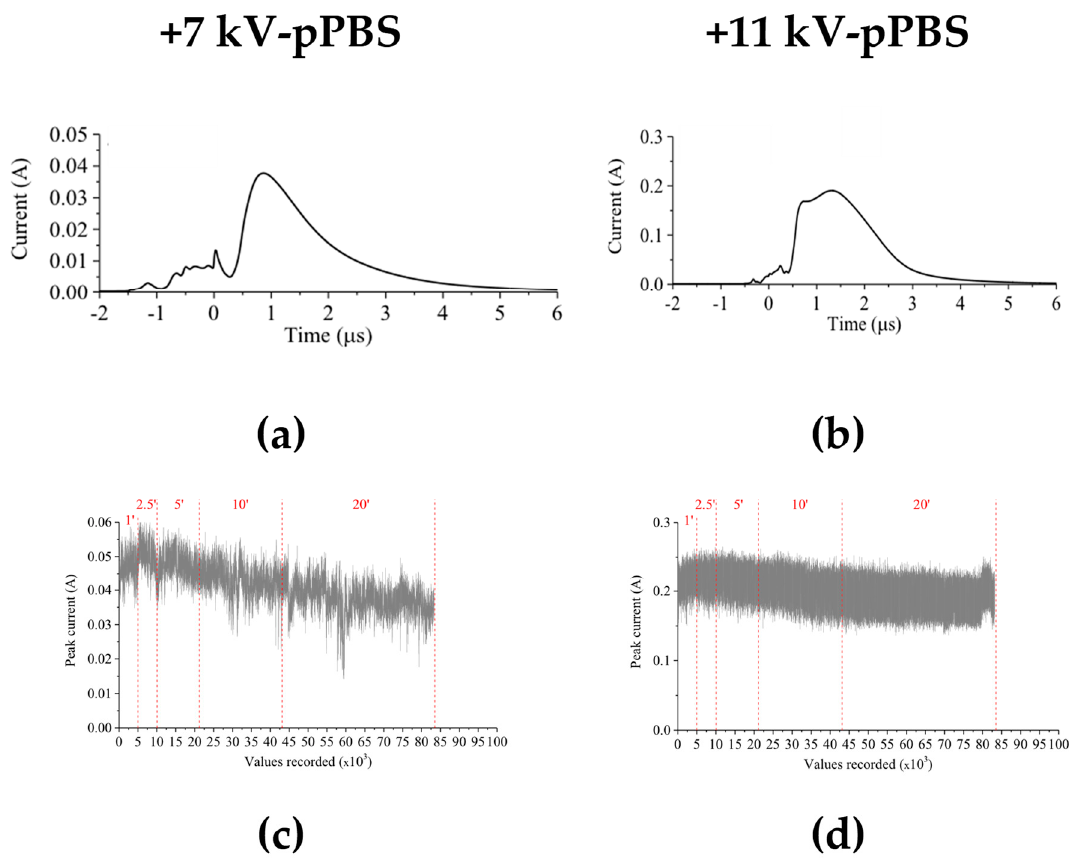
Figure 1. Assessment of the electrical characteristics of the non-thermal plasma (NTP) multi-jet source during 20 min. treatment of PBS + / + at +7 kV ( a , c ) and + 11 kV ( b , d ) pulses peak values. Current signals, averaged from 128 single recordings ( a , b ) and the evolution of the maximum current ( c , d ) were measured during the treatment process.